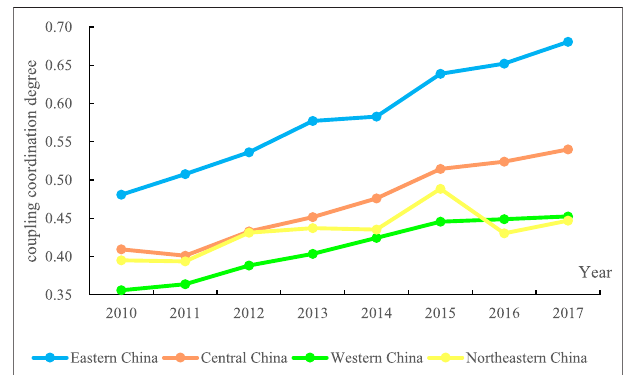
FIGURE 5 | Temporal variation of the coupling coordination degree during 2010 – 2017.